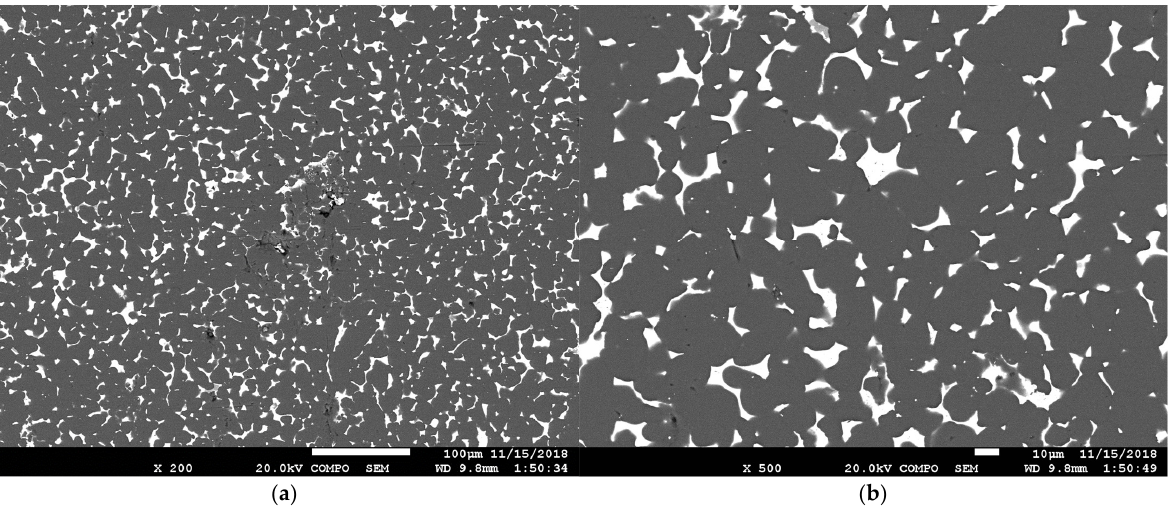
Figure 13. Metallographic photo of the spray-formed alloy ingot.